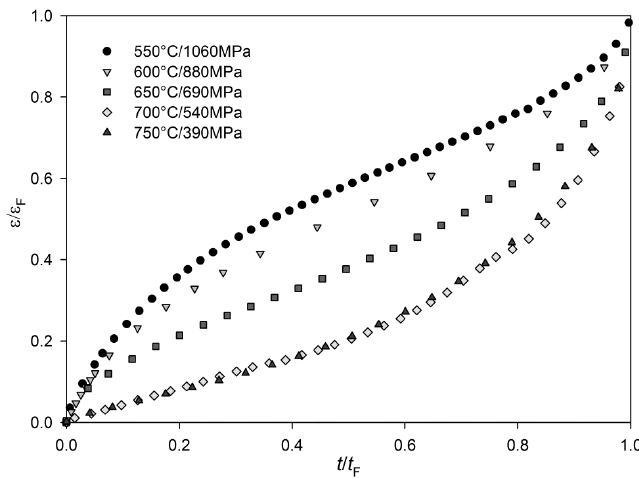
Figure 2. Creep curves may take significantly different shapes dependent on applied stress and temperature.